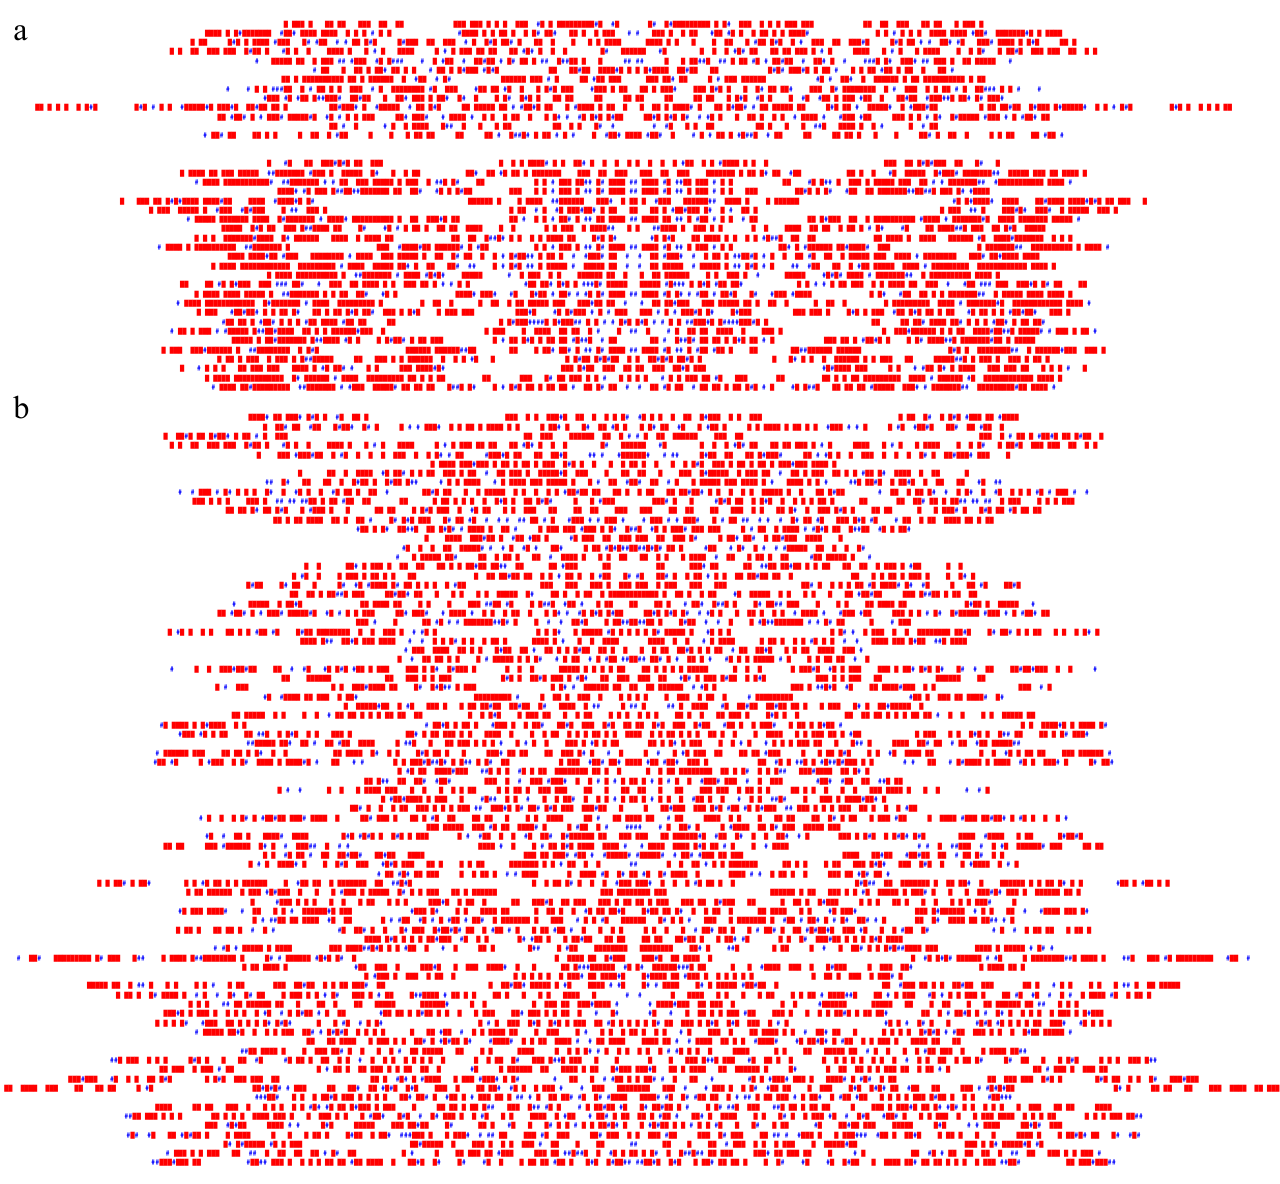
Figure 6. All Hypoxylon sp. CO27-5 stwintrons exhibited an underlying internal symmetry. ( a ) A two- dimensionally horizontal schematic representation of internal symmetry is shown for each of the 38 sequence-similar sister stwintrons, the 13 sheared sister stwintron at the top and the 25 full-length sister stwintrons below with the two unique EC38 sister stwintrons at the bottom. The stwintrons are vertically ordered as the order in which they appear in Supplementary Materials Table S1. The midpoints of the symmetry, as indicated by the MAFFT alignment of each stwintron sequence with its own reverse complement sequence, are aligned at the centre of the figure, resulting in a visual effect where the left and right half of the panel are mirrored. ( b ) The same representation of the internal symmetry in each of the uniquely occurring (evolutionary older) [D1,2] stwintrons. The 81 stwintrons are vertically ordered by increasing the match number of the stwintron amongst the hits scored in the primary search model for [D1,2] stwintrons (i.e., the order in which they appear in Supplementary Materials Table S1). The schematic representation of internal symmetry was derived from the one-on-one alignment of a stwintron sequence with its own reverse complement sequence by MAFFT using the E-INS-I module and employing PAM matrices to reduce the number of gaps introduced and limiting the extent of these gaps. A red square represents positions in the alignment where the nt (irrespective of its identity) in the stwintron sequence was the same as in its reverse complement sequence. The blue # (number) sign represents positions in the alignment